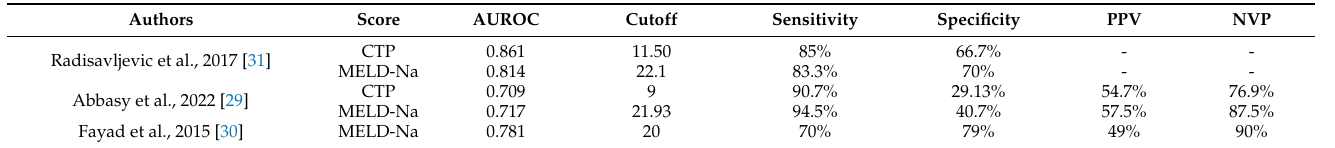
Table 7. Score values in patients with alcoholic liver